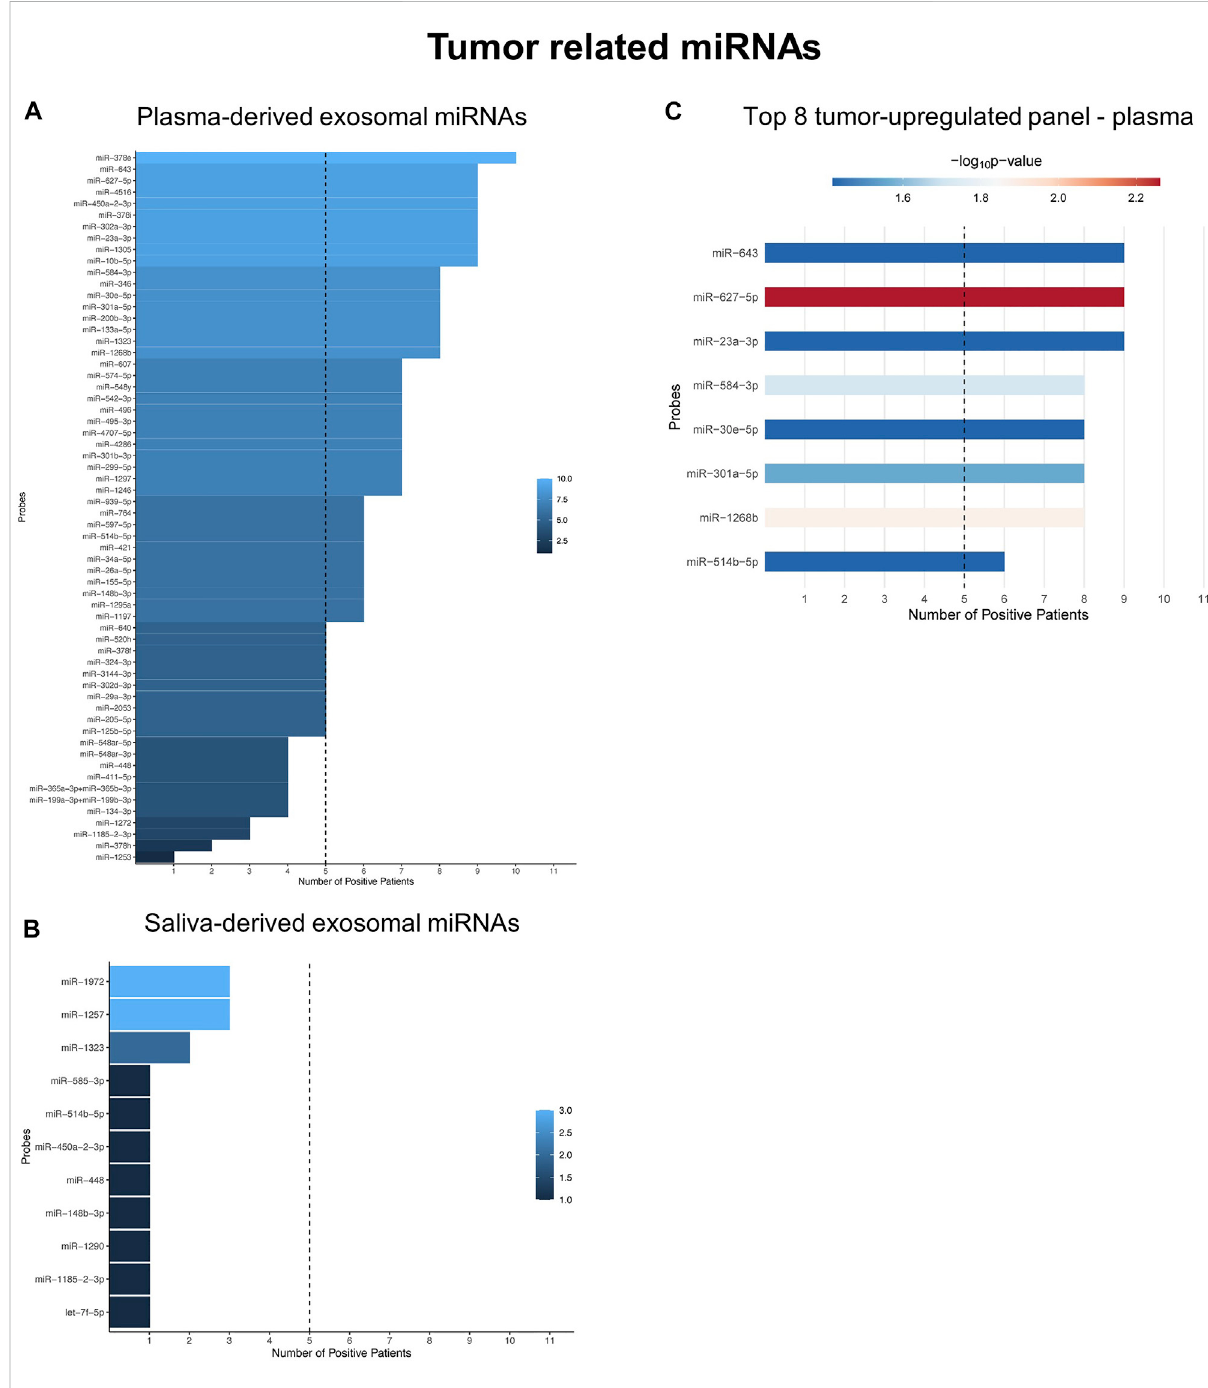
FIGURE 4 Tumor-related miRNAs are potent diagnostic biomarkers only in plasma-derived exosomes. (A,B) Waterfall plots of binarized tumor-related exosomal miRNAs from plasma (A) and saliva (B) showing the number of HNSCC patients with positive expression. miRNAs exceeding the threshold of 50% (dashed line) were considered tumor- upregulated . (C) Shows the Top eight tumor-upregulated exosomal miRNAs from plasma with discriminatory potential between HNSCC patients and HD, based on unpaired Wilcoxon